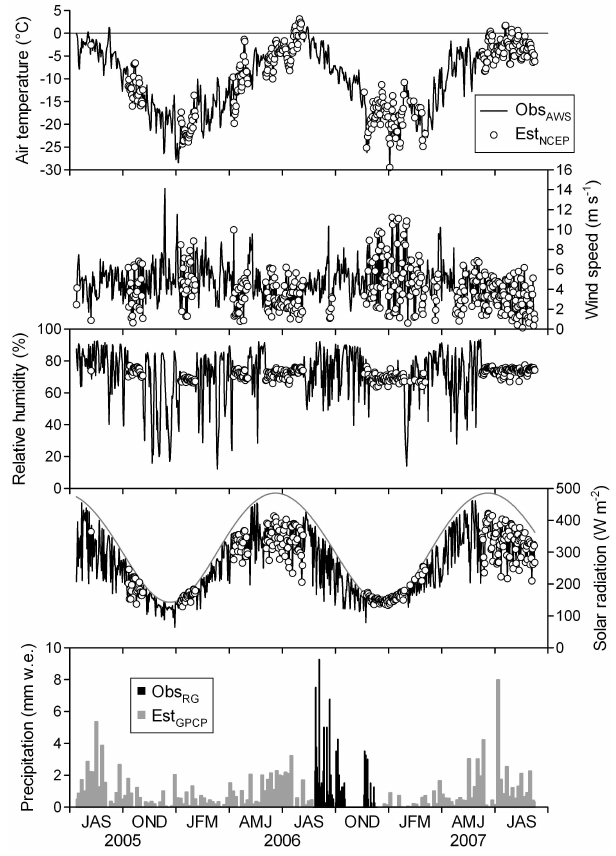
Fig. 2. Meteorological records observed at the summit of the Gre- goriev Glacier from July 2005 to September 2007. The upper to lower panels respectively show daily values of air temperature, wind speed, relative humidity, solar radiation, and precipitation. Lines and circles in the panels (except precipitation) indicate observed and estimated variables, respectively. In the lowermost panel (pre- cipitation), black and grey bars represent observed and estimated daily precipitation, respectively. The grey line in the panel showing solar radiation represents the solar irradiance calculated for the top of the atmosphere.